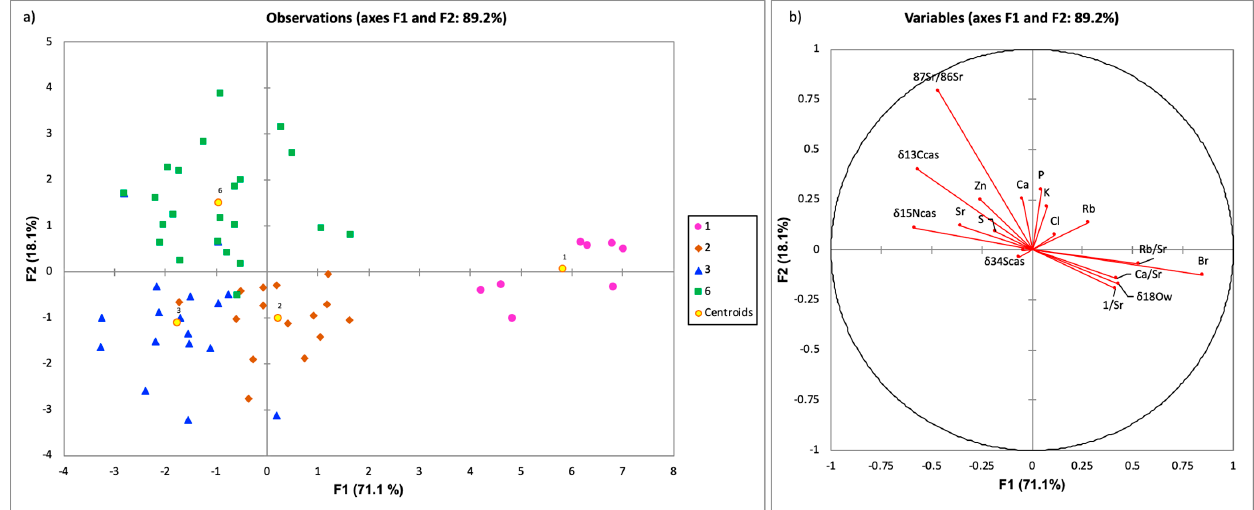
Figure 6. Discriminant function score plot ( a ) and a discriminant loadings plot ( b ) for milk samples collected in 2014 on four different geological origins (1—Cretaceous: Carbonate Rocks and Flysch, n = 8; 2—Jurassic-Triassic: Carbonate Rocks, n = 15; 3—Neogene: Carbonate Rocks, Paleogene: Deposits, n = 17; 6—Quaternary: Deposits, n = 24).